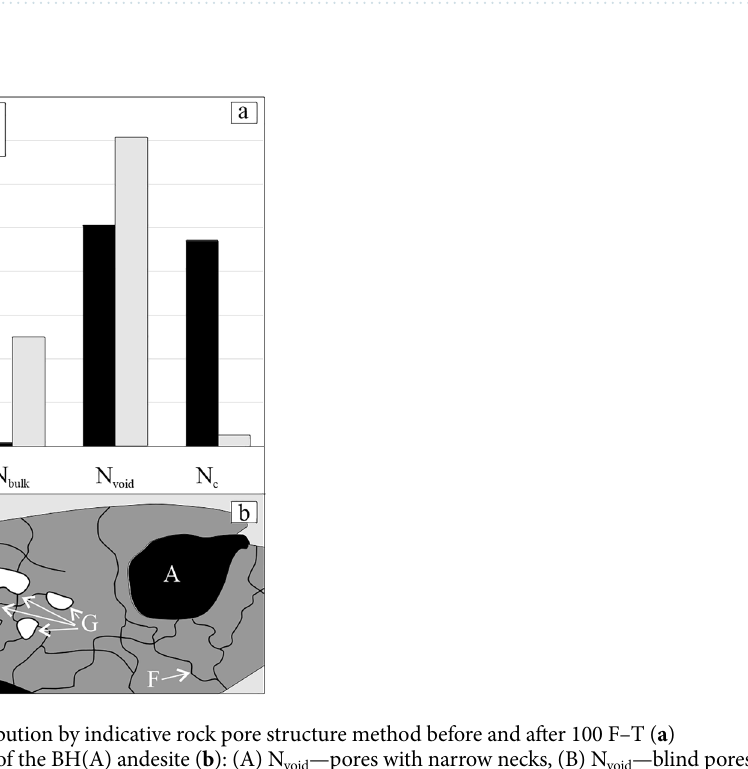
Table 1. Total and effective porosity, mean values of imbibition slopes C(I) from triplicate measurements and degree of saturation of BH(A) 4 specimen before and after F–T cycling.